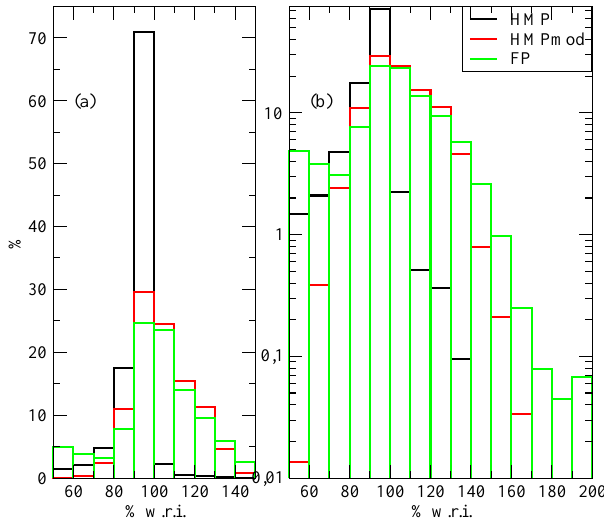
Figure 6. Observed distributions of RH i in 2015 for cases of RH i between 50 and 150% with linear vertical RH i scale (a) and be- tween 50 and 200% and with logarithm vertical RH i scale (b)